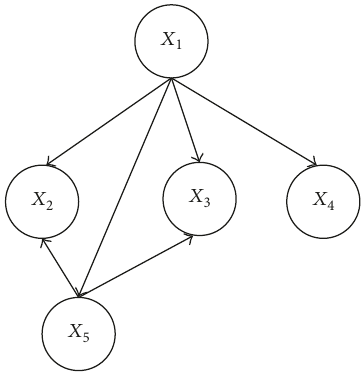
Figure 1: An example of attribute dependency